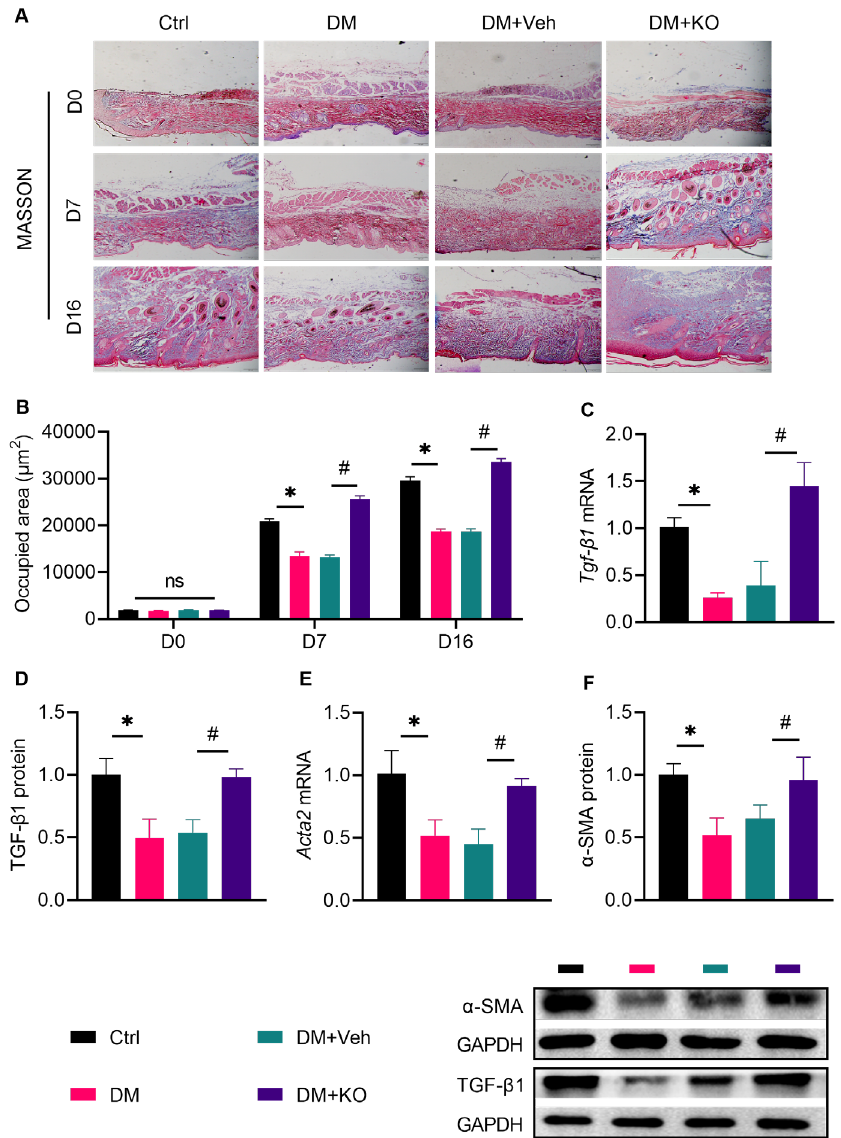
Figure 5. KO facilitated cutaneous collagen deposition in the diabetic wounds. ( A ) Masson’s trichrome staining was performed to assess ( B ) the deposition of mature fibers on D0, D7 and D16. ( C ) Tgf-β1 mRNA levels, ( D ) TGF-β1 protein levels, ( E ) Acta2 mRNA levels, and ( F ) α-SMA protein levels were determined. The data were summarized as means ± SD. *, p < 0.05 vs. Ctrl; #, p < 0.05 vs. DM. Actα2 , actin α 2; α-SMA, α-smooth muscle actin. The other abbreviations are the same as in